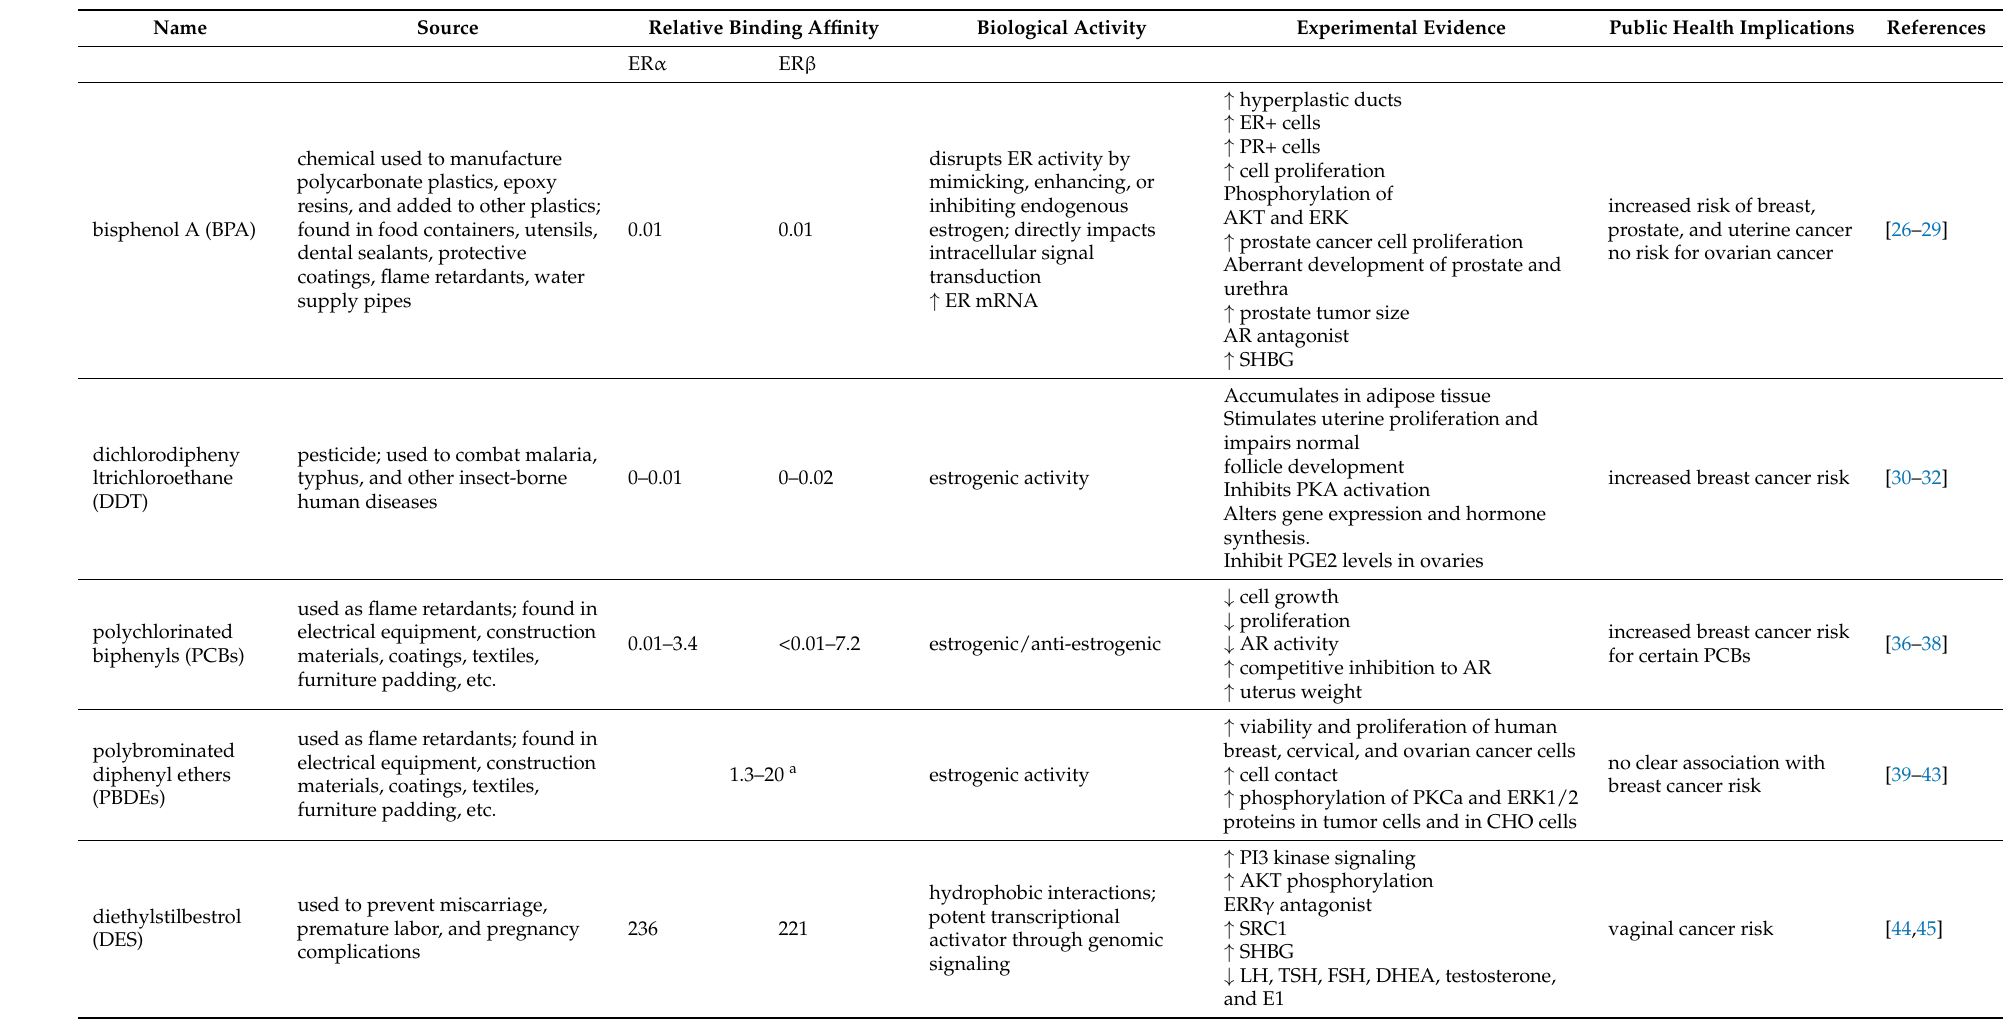
Table 1. Various xenoestrogens and their implications for cancer. Compilation of ten types of xenoestrogens and their sources, biological and experimental evidence from pre-clinical studies, and implications towards cancer. Relative binding affinities were adapted from Kuiper et al. [25], unless otherwise noted, with E2 set as